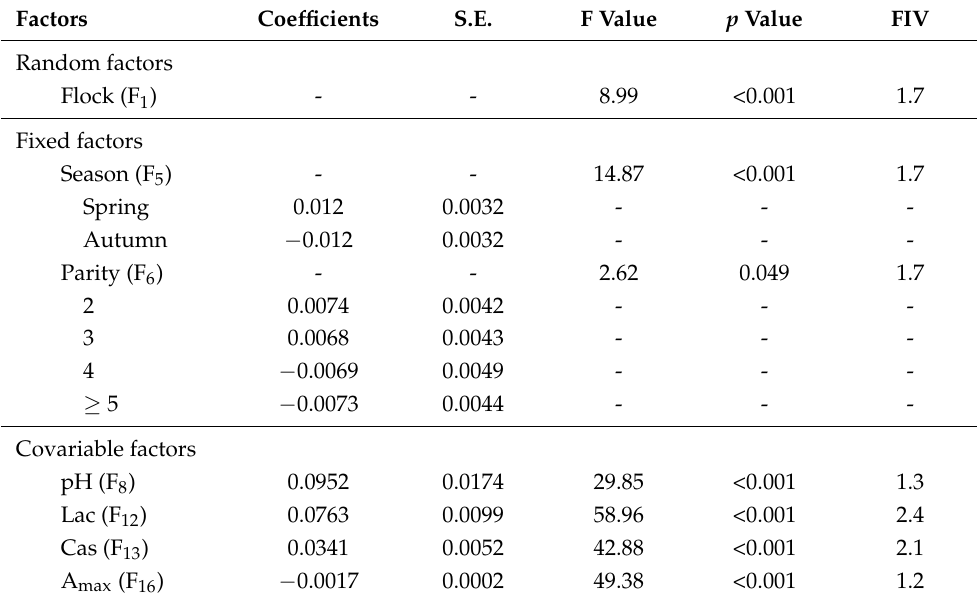
Table 5. Determinants for curd efficiency (CE) according to GLM ( n =